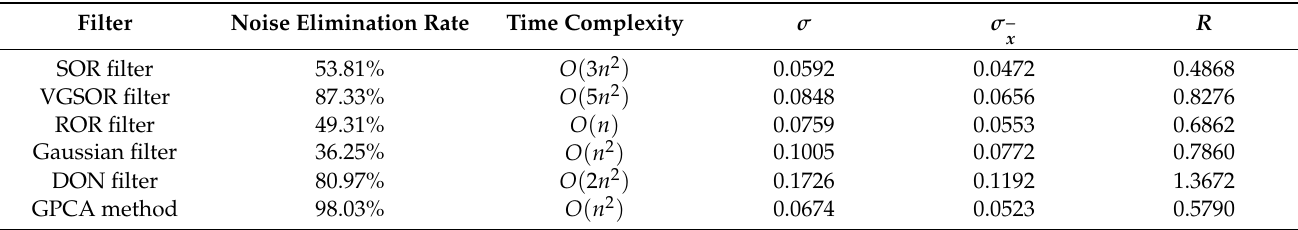
Figure 8. Segmentation and splicing of ground point clouds: ( a ) the two-dimensional wall is restored to three-dimensional point cloud data. ( b ) Other point clouds beside the wall: these point clouds are made up of ground and noise. ( c ) The data in ( b ) are roughly segmented by using the included angle of the normal vector. Point clouds on the ground are mostly grouped into the same category (the same color). However, many misclassified points still exist. ( d ) The classification results of the previous step are further segmented by the KNN principle, and the complete plane point cloud is obtained. ( e ) The ground and wall point clouds are joined together. Table 1. Measurement parameters of several